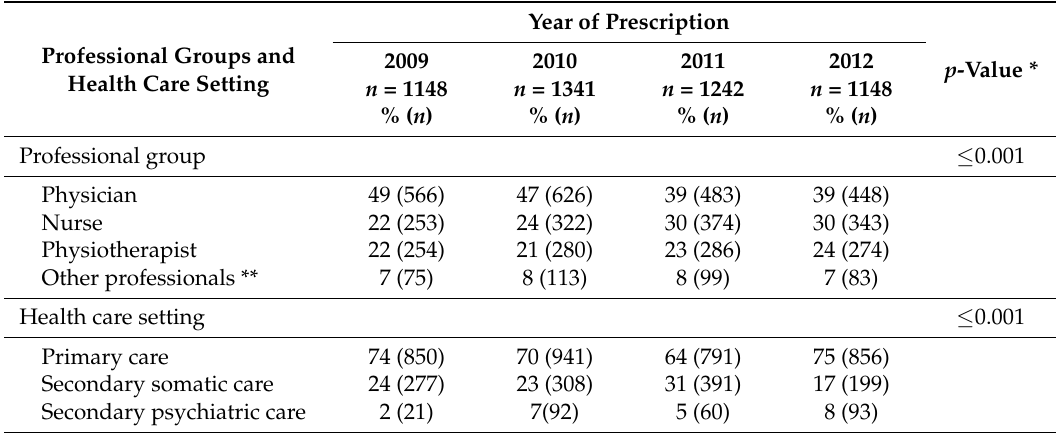
Table 4. PAP delivery by health care professional and setting over time ( n =